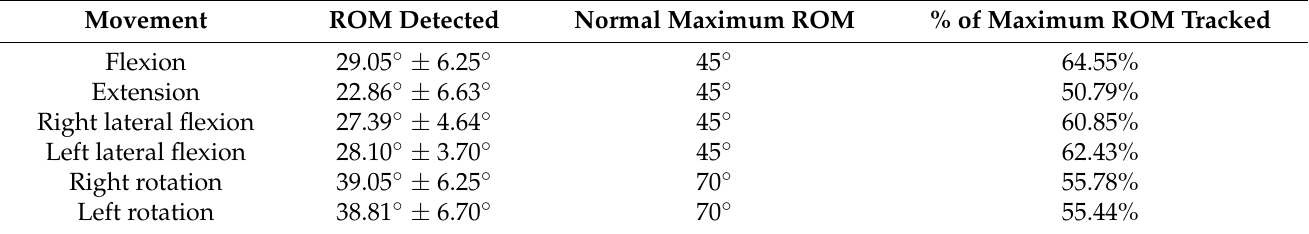
Table 1. Mean values and standard deviation of cervical range of motion measurements, and their relationship with normal mobility